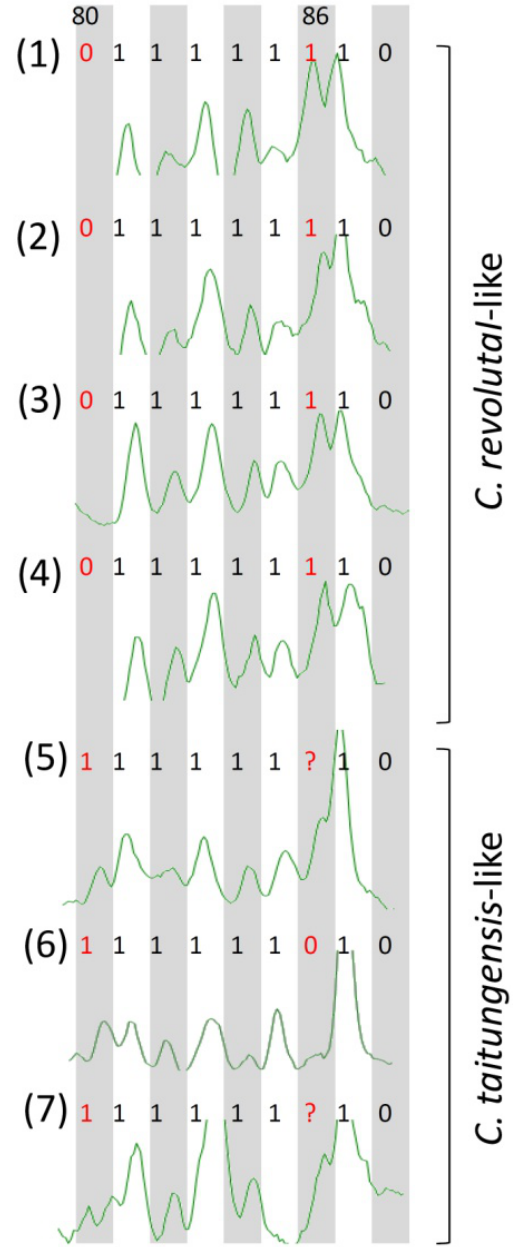
Figure A2. Examples of the ABI prism graphs revealing the loci with present (1) and absent (0) peaks. The question mark (?) indicates the missing (ambiguous) allele. Examples were separated to seven populations: ( 1 ) the wild population of C. revoluta in Ryukyus; ( 2 ) the wild population of C. revoluta in Fujian; ( 3 ) the C. revoluta -like cultivated population of C. revoluta in Taiwan; ( 4 ) the C. revoluta -like cultivated population of C. taitungensis in Taiwan; ( 5 ) the wild population of C. taitungensis in Taiwan; ( 6 ) the C. taitungensis -like cultivated population of C. taitungensis in Taiwan; and ( 7 ) the C. taitungensis -like cultivated population of C. revoluta in Taiwan. The polymorphic loci represented in this example graph are indicated in red ( i.e. , the 80 and 86 sites), which separate these individuals to the C. revoluta -like and the C. taitungensis -like groups in genetic